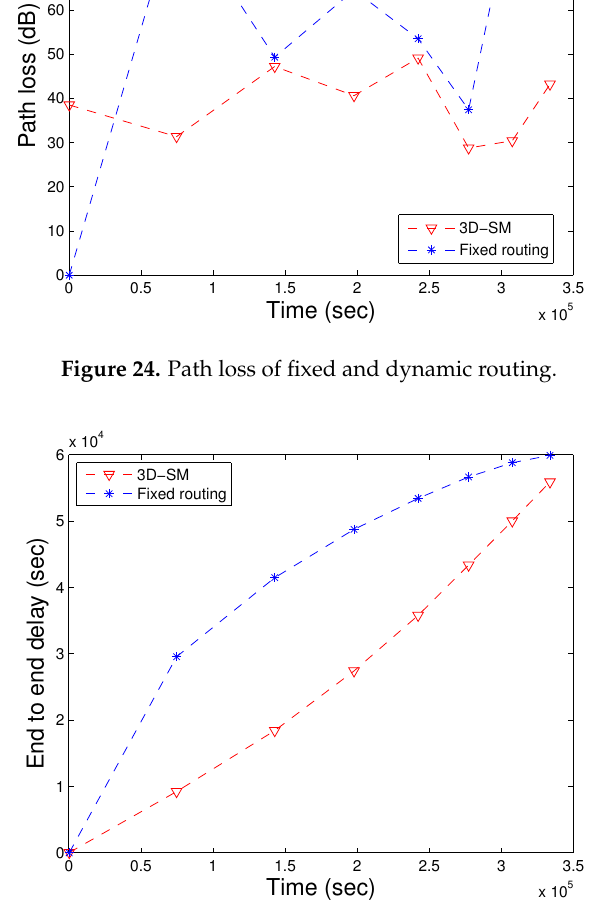
Figure 25. End-to-end delay of fixed and dynamic